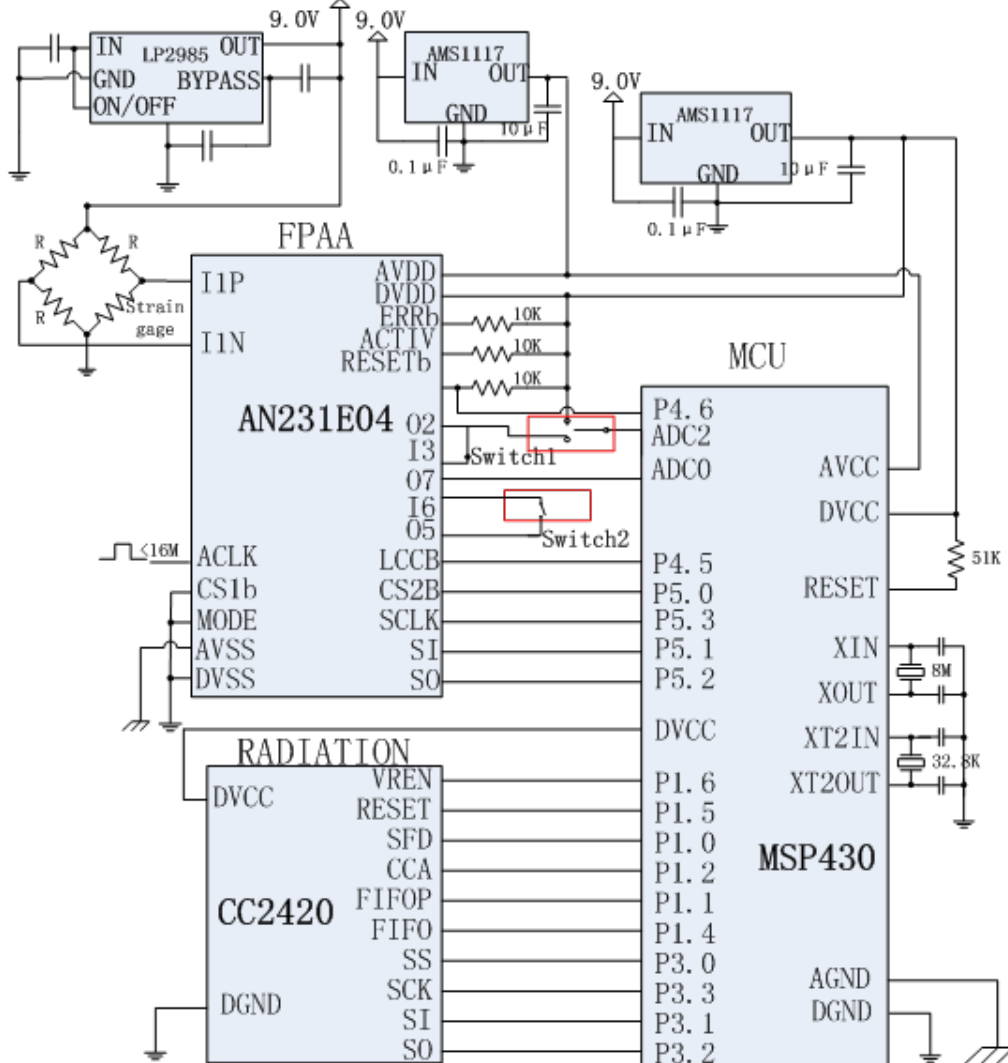
Figure 11. Circuit design of the FPAA-based self-healing